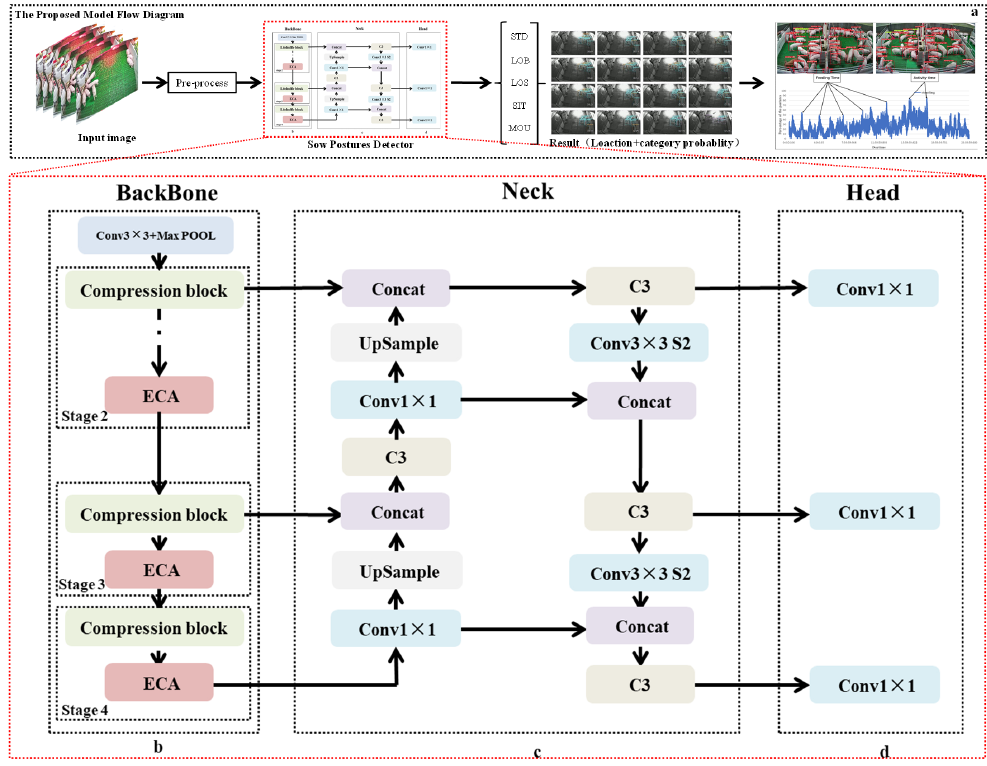
Figure 3. Pig posture detection flowchart. ( a ) Specific process of the model; ( b ) Backbone of the model; ( c ) Neck of the model; ( d ) Head of the